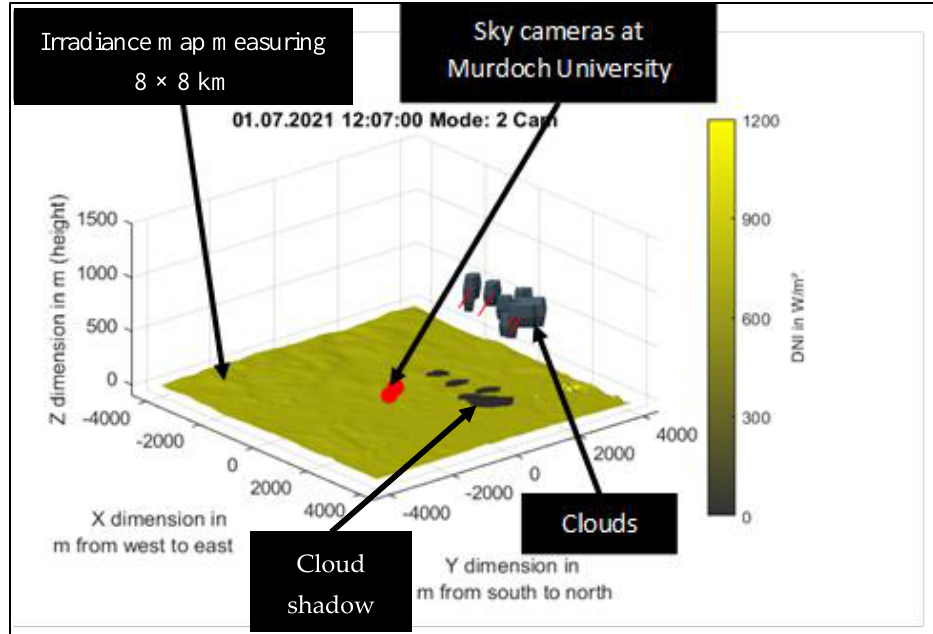
Figure 8. A three-dimensional virtual modelling space with cloud models and a topographical map around Perth with spatial DNI information.